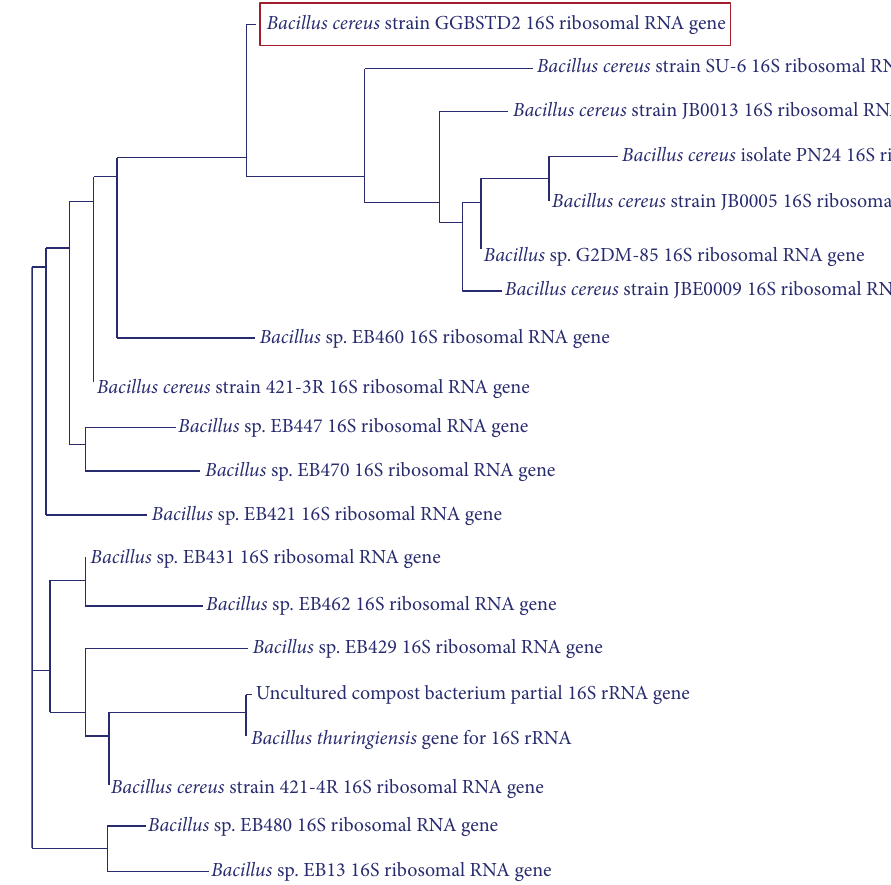
Figure 1: Neighbor joining phylogenetic tree of full 16S rRNA gene sequences showing the relationship among Bacillus cereus GGBSTD1 and representatives of some related taxa. The sequence data for several closely related Bacillus cultures were recovered from GenBank and included in the tree.